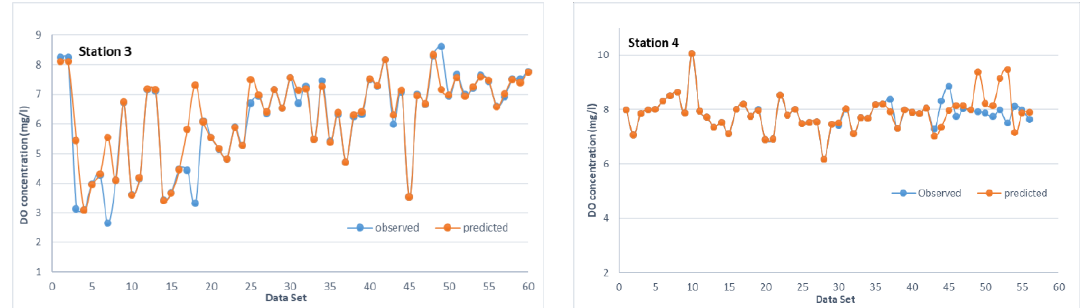
Figure 6. Comparison between actual and predicted value for DO.